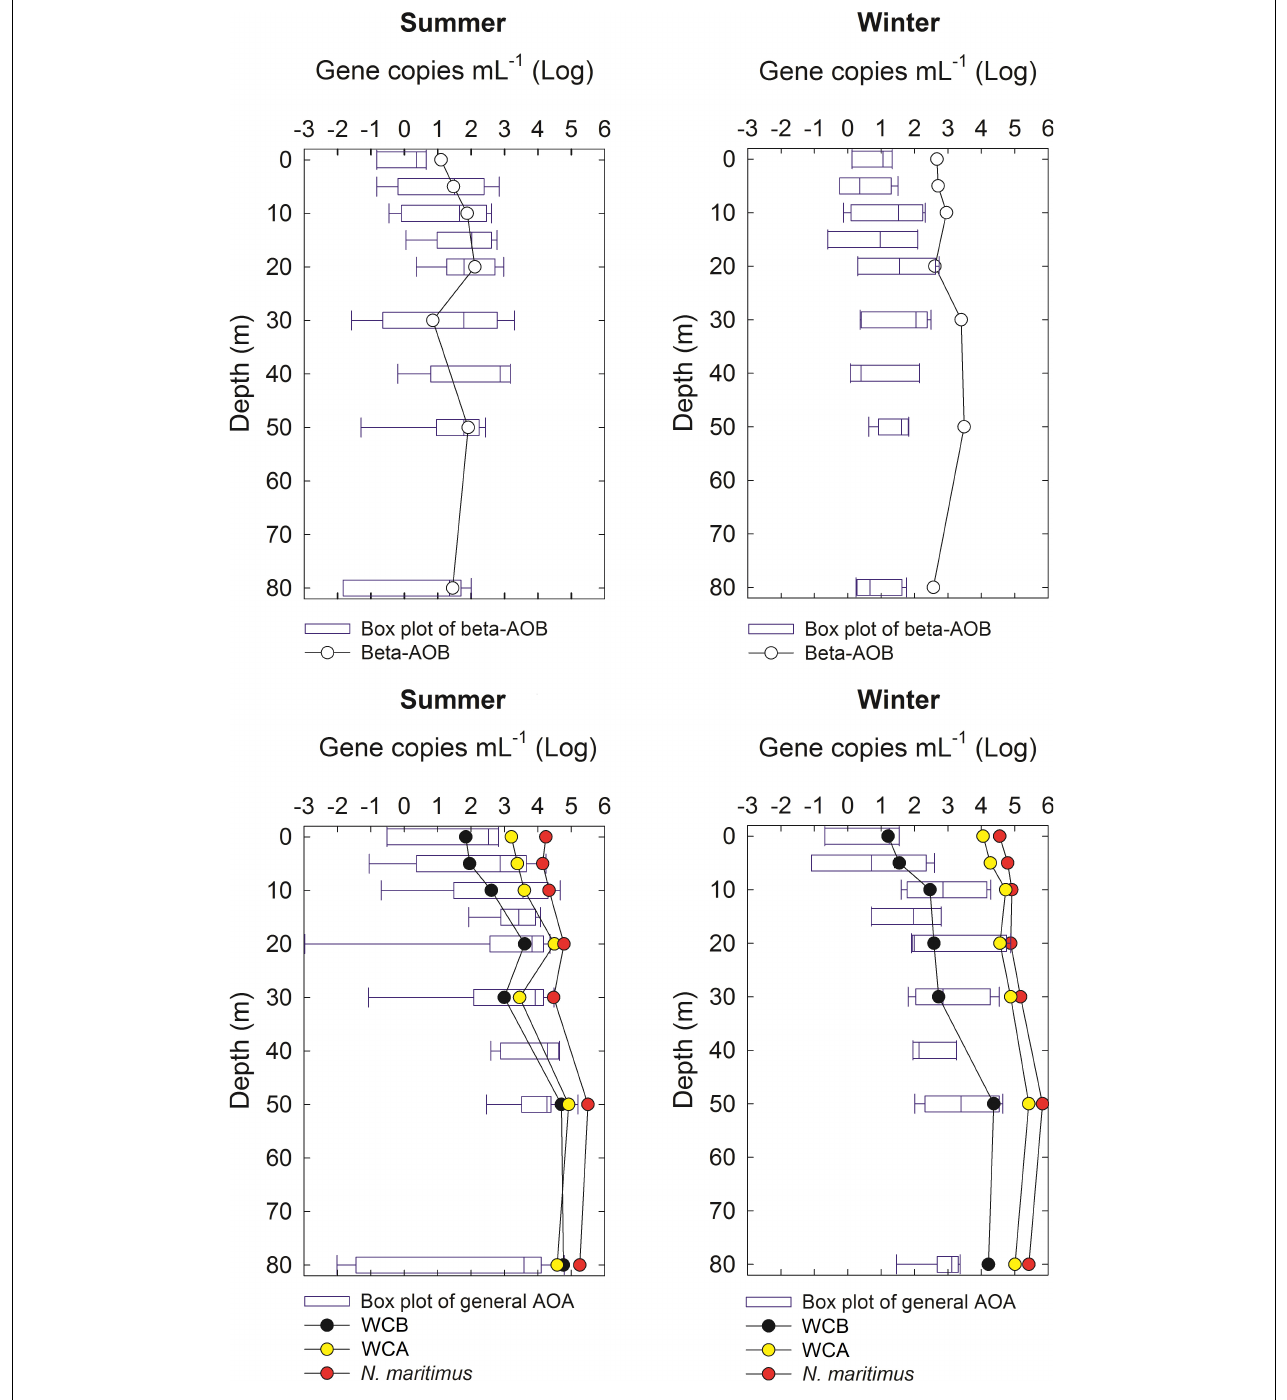
FIGURE 4 | Vertical profiles of the main ammonia-oxidizer ecotypes ( amoA gene counts in a log-transformed scale) at the St.18 during two contrasting oceanographic months, that is, a representative month for the unfavorable (August 2011, austral winter) and favorable conditions (December 2011, austral summer) for upwelling. For the sake of comparison, the seasonal average for bAOB and general AOA are shown in blue. Error bars are standard deviations.